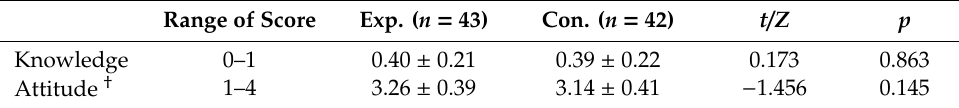
Table 3. Homogeneity of the two groups based on general characteristics.